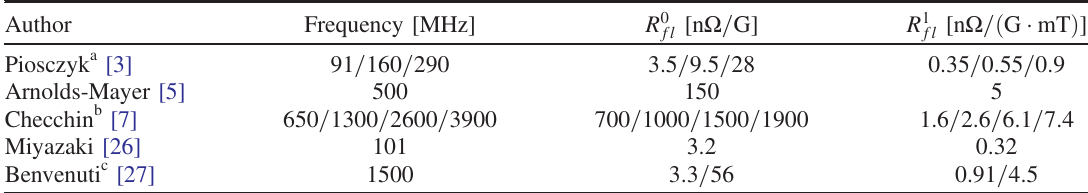
TABLE I. Coefficients R 0 bottom lines are for Nb = Cu.